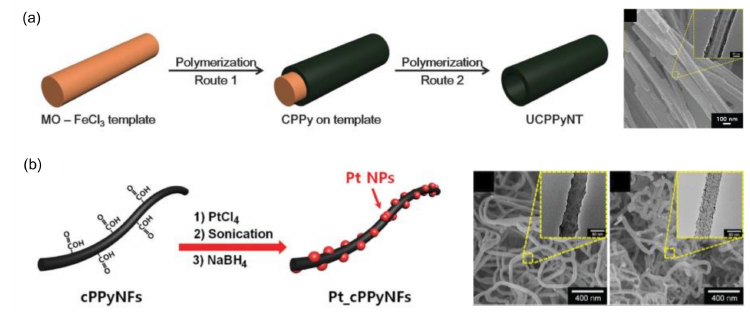
Figure 2. ( a ) Synthesis of methyl orange–iron chloride template CPPy nanotubes for 17 β